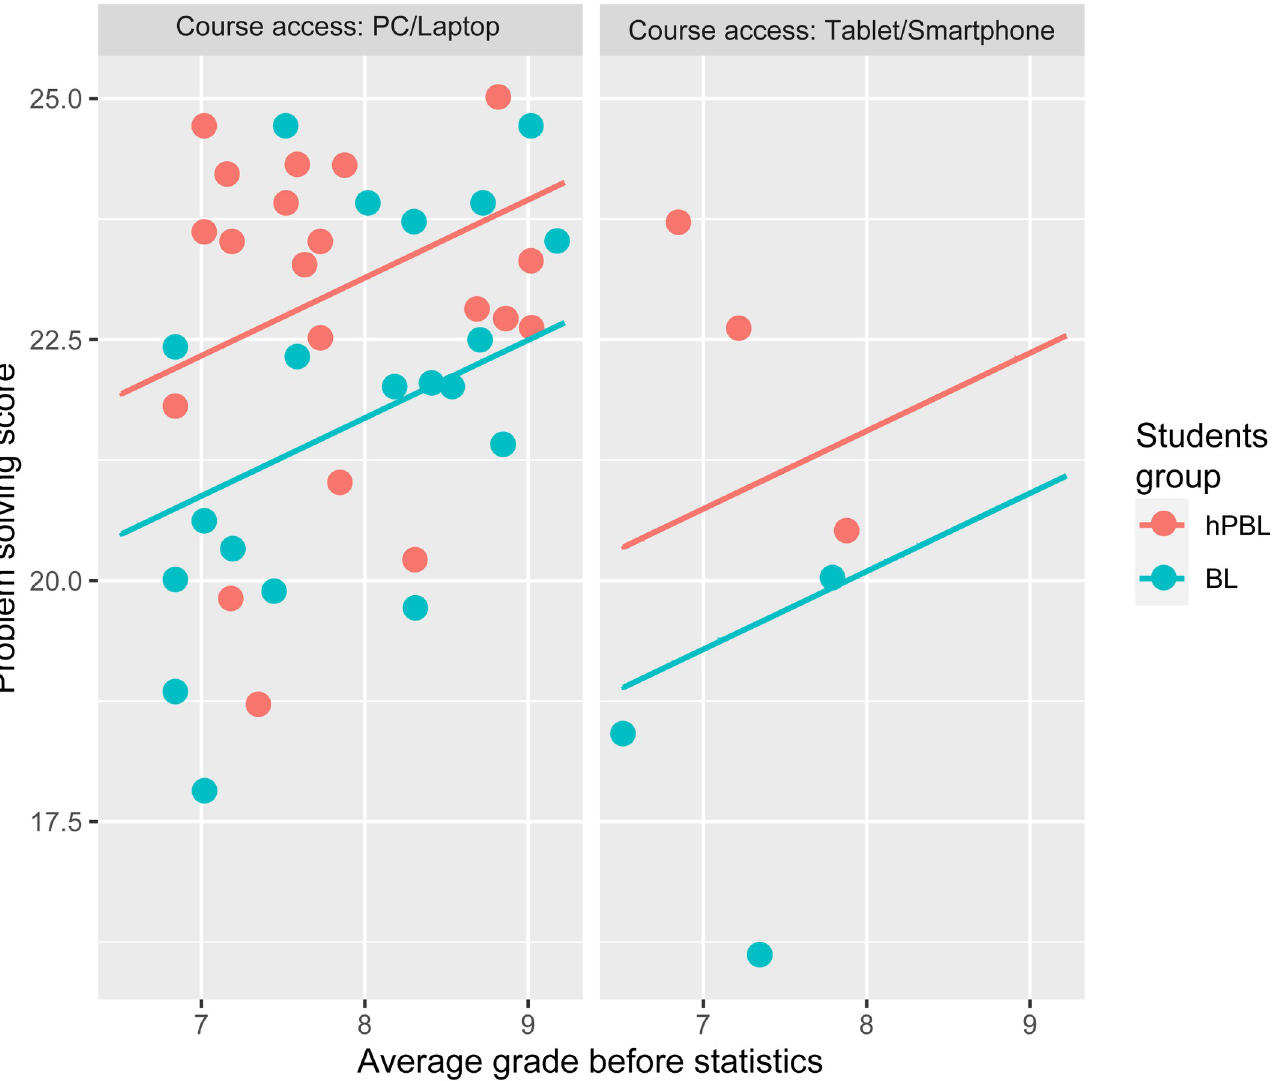
Fig 2. The relationship between the problem solving score and factors associated with it in multivariate regression model. hPBL –hybrid Problem Based Learning, BL –Blended Learning.